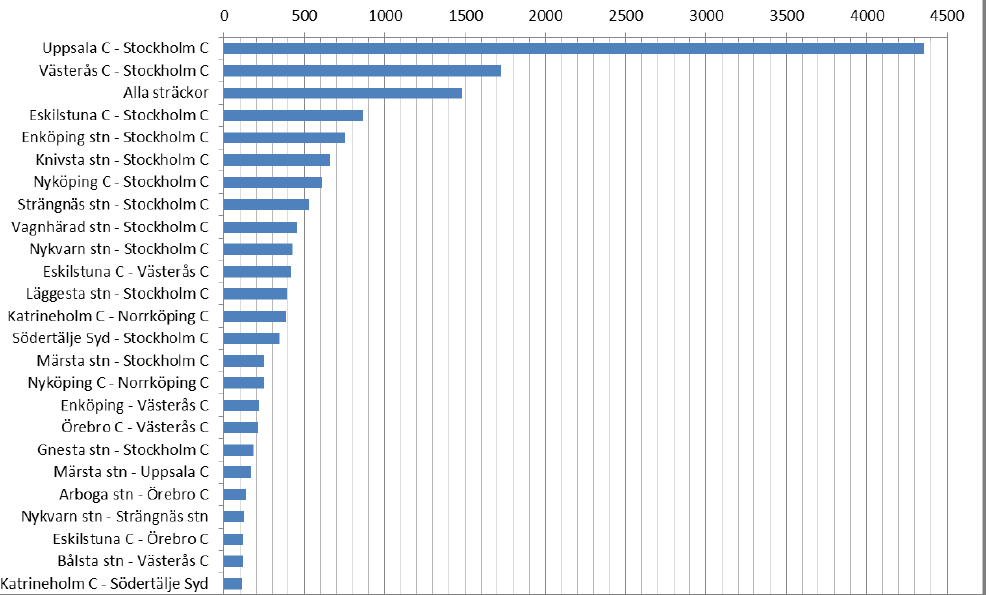
Figure 2: Average number of tickets sold per major commuting route in the first four months. Source: MÄLAB, 2018